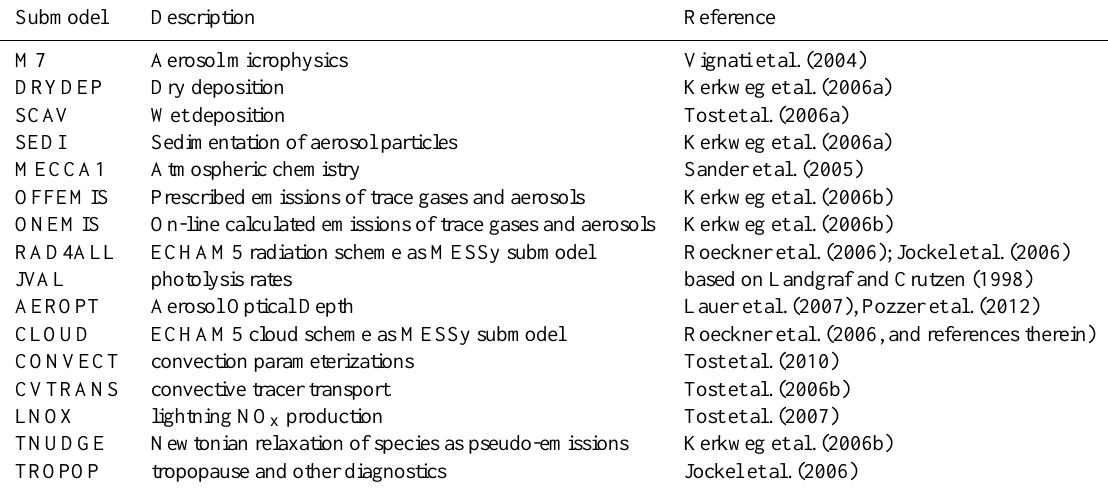
Table 1. EMAC sub-models used in this study.